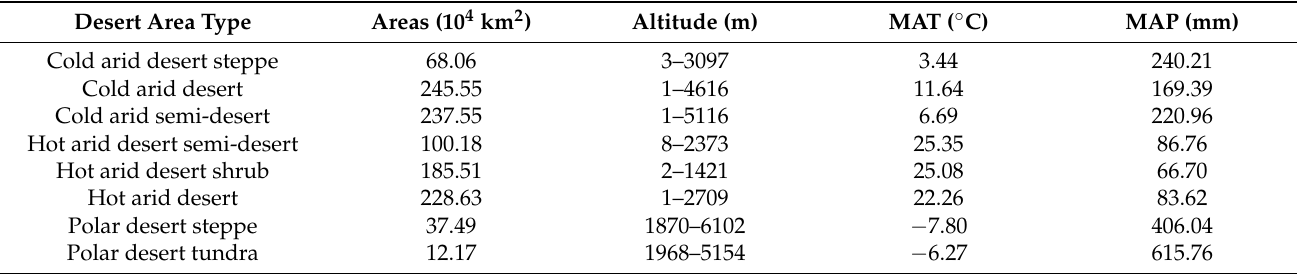
Table 1. General characteristics of different desert areas over the Silk Road Economic Belt. MAT and MAP are mean annual air temperature and precipitation between 1982 and 2015,